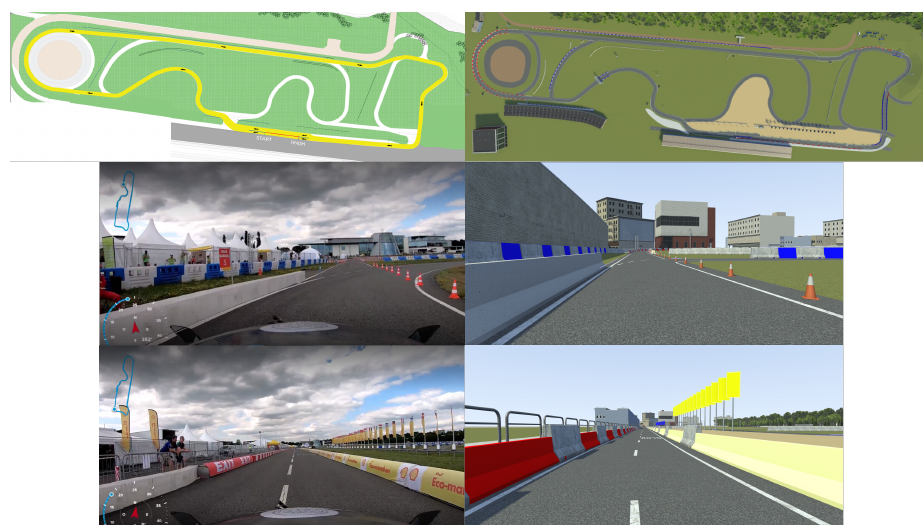
Figure 5. Numerical model of the track. Comparison between real and virtual